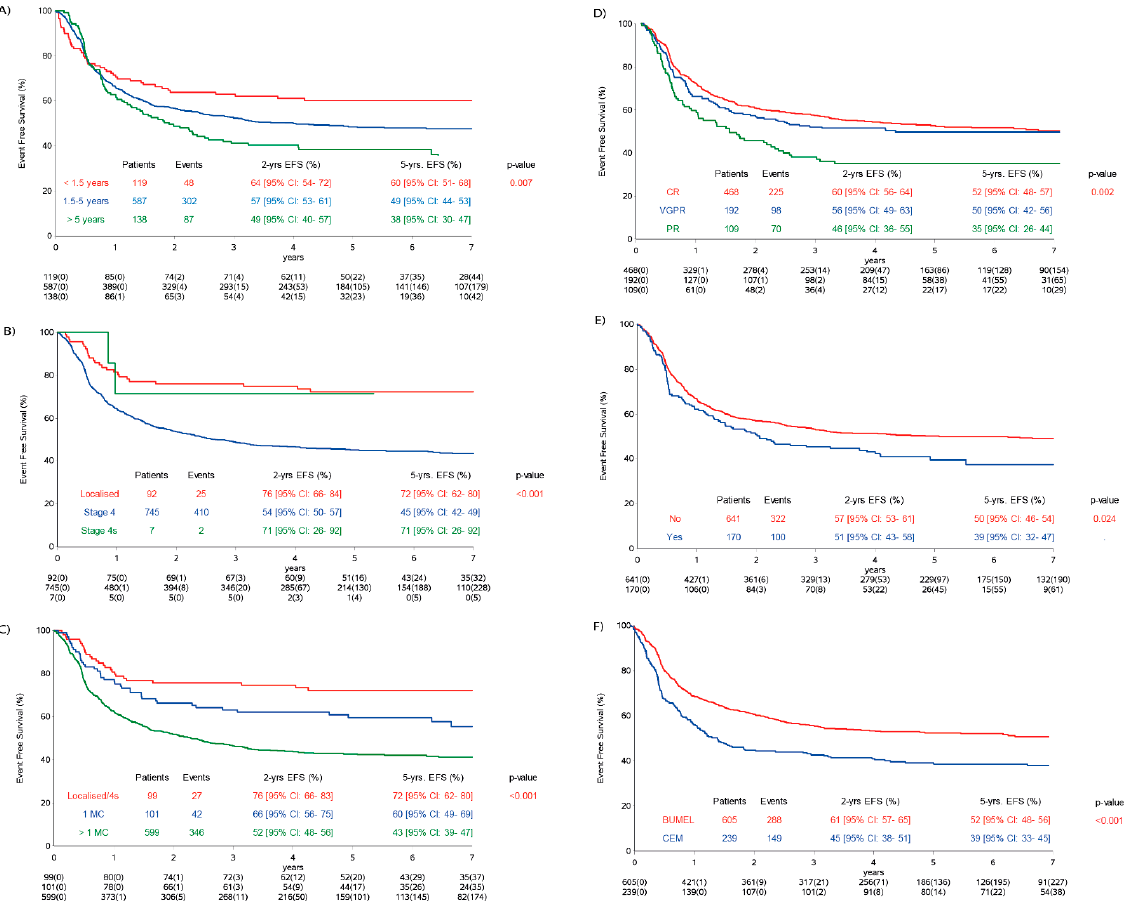
Figure 3. Influence of risk factors within the analysis population on event-free survival (EFS). ( A ) EFS and age; ( B ) EFS and stage; ( C ) EFS and metastatic compartments (MC) localised and 4s stage vs. stage 4 (one MC vs. multiple MC); ( D ) response status prior to maintenance phase: CR (complete remission), VGPR (very good partial remission) and PR (partial remission) and ( E ) EFS and TVD (topotecan, vincristine and doxorubicin). TVD added = yes and TVD not added = no. ( F ) Type of high-dose chemotherapy = BuMel (busulfan and melphalan) and CEM (carboplatin, etoposide and melphalan).